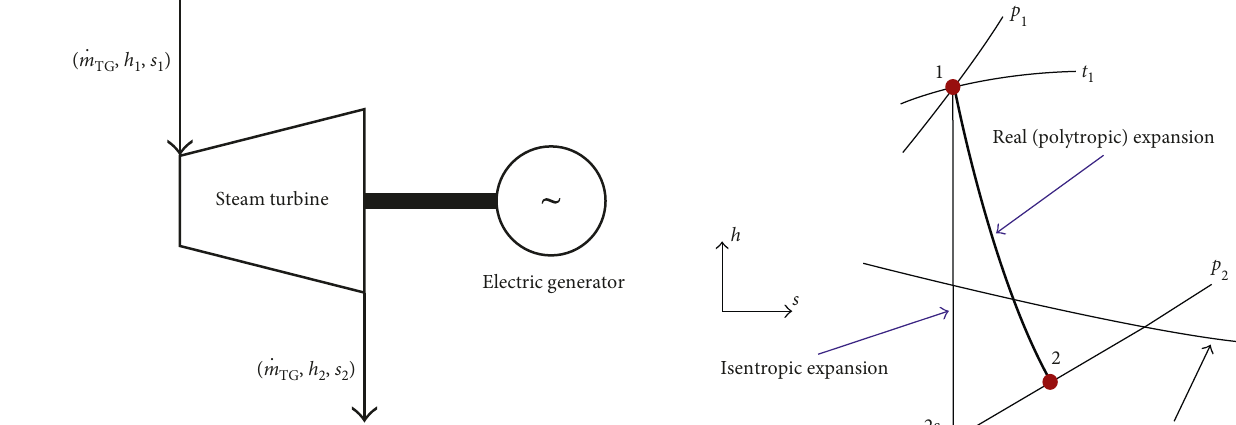
Figure 1: TG steam turbine along with main operating parameters connected to an electric generator. Figure 2: Steam turbine real (polytropic) and ideal (isentropic)